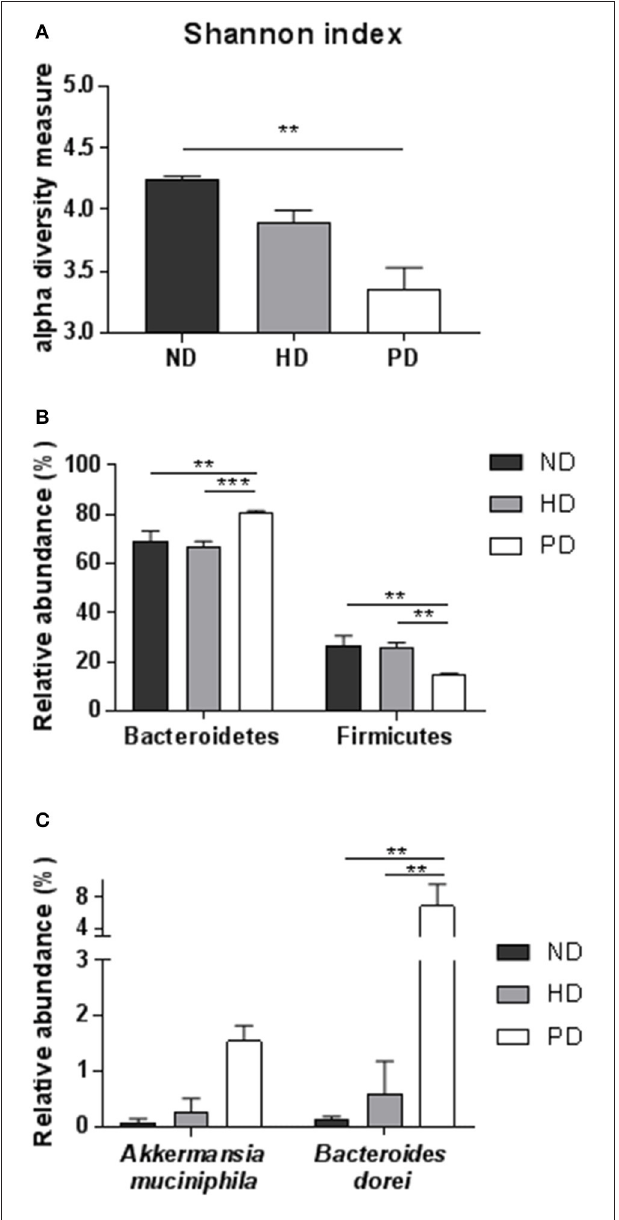
FIGURE 6 | (A) Alpha diversity using Shannon index of the fecal microbiota for each groups. (B) Relative abundance of major Phylum (Bacteroidetes and Firmicutes) for each group. (C) Relative abundance of most significant species, using RDP v11.4 databank in fecal samples of ND, HD, or PD mice. Graphs are displayed as mean ± SEM. ** p < 0.01; *** p < 0.001, One-Way Anova followed by Kruskal–Wallis